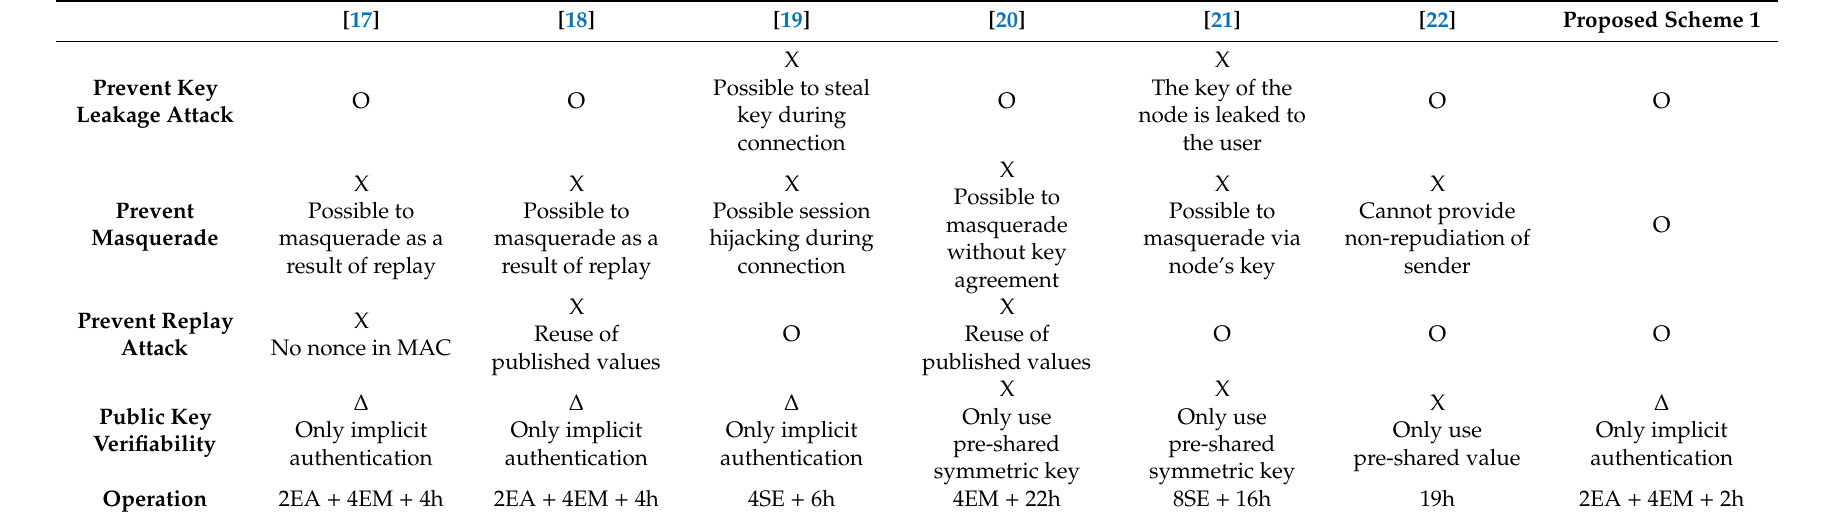
Table 3. Comparison of Scheme